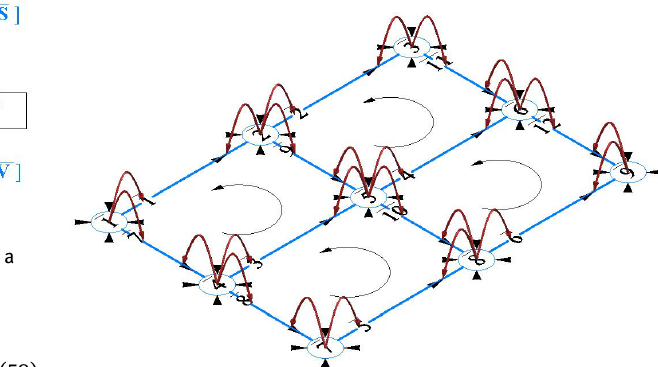
Figure 17: Coboundary process performed on the primal cell com-